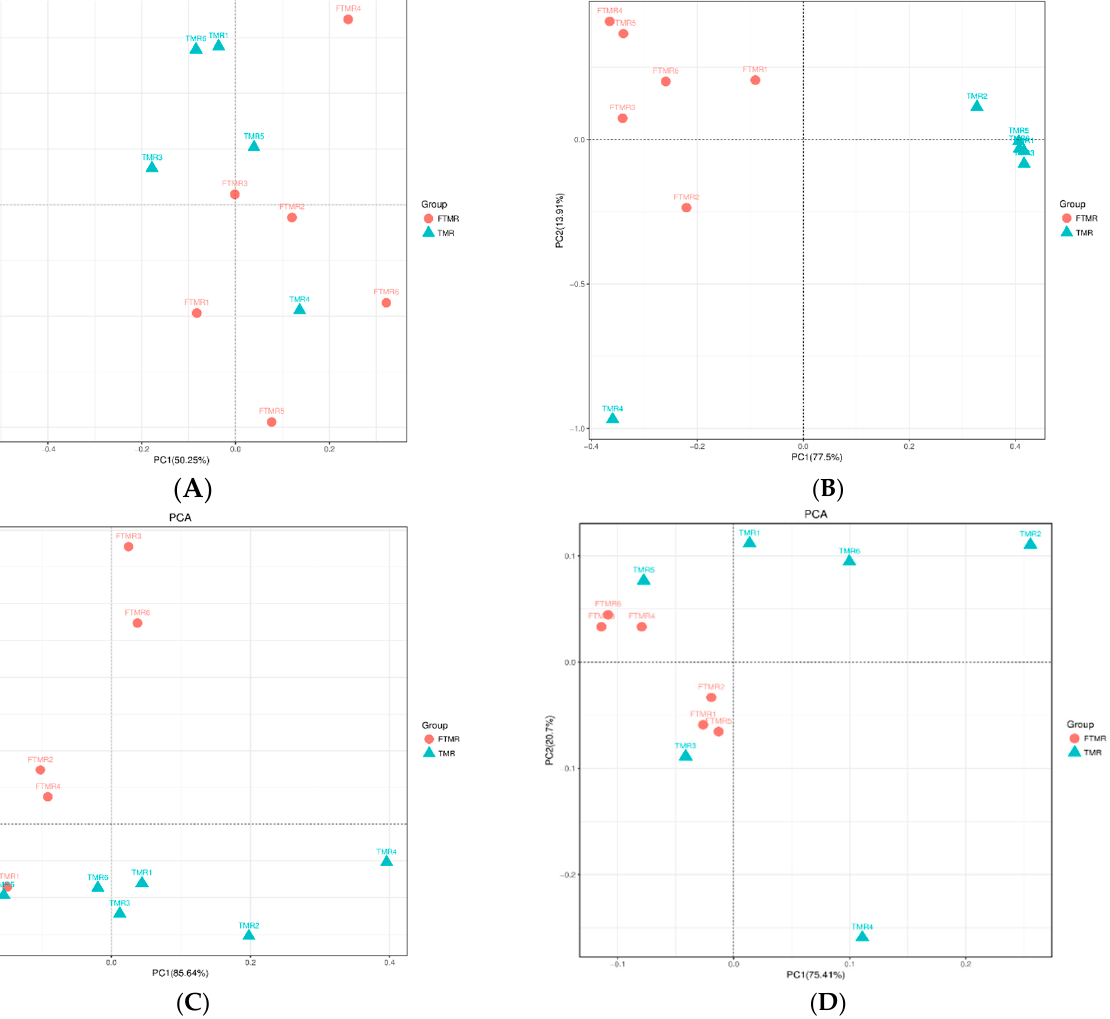
Figure 4. PCA of rumen microbial communities. Each point represents a sample, and different colors represent different groups. The closer the distance between two points, the less the difference in microbial community structure between the two samples. Weighted PCA by ruminal bacteria ( A ), anaerobic fungi ( B ), protozoan ( C ), and archaea ( D ). TMR, total mixed ration; FTMR, fermented total mixed ration.